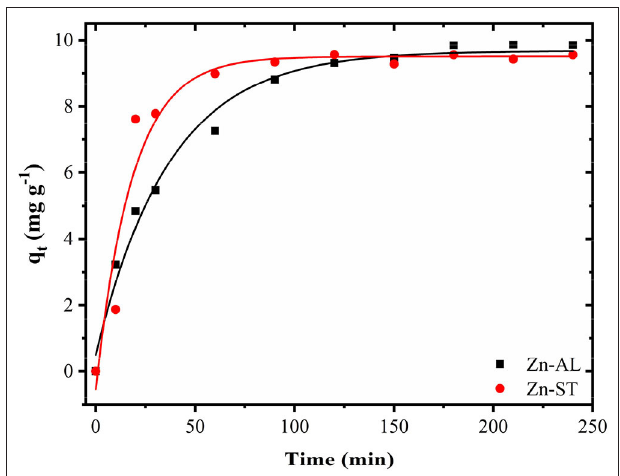
FIGURE 9 | Progressive removal of Cu (II) ions from aqueous solutions using Zn-AL and Zn-ST as